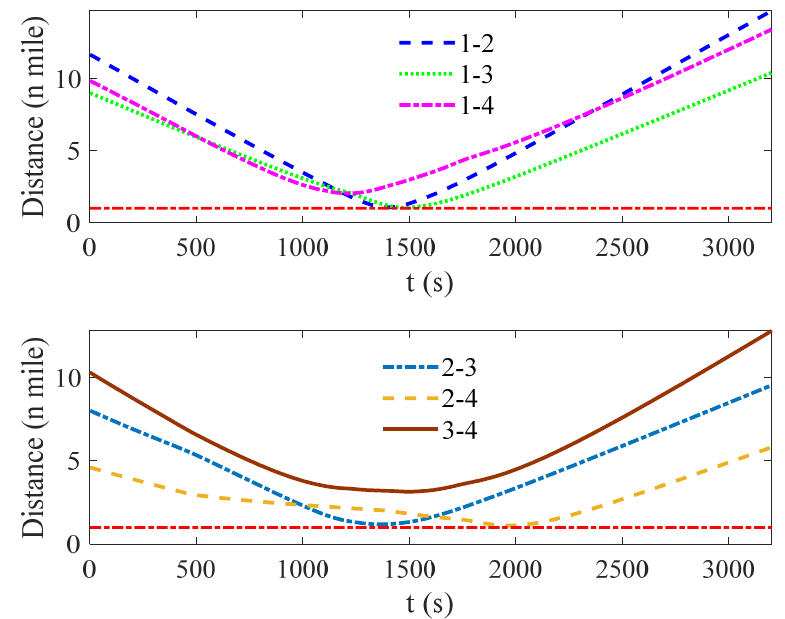
Figure 10. The situation of four ships at t = 3200 s in scenario 1.